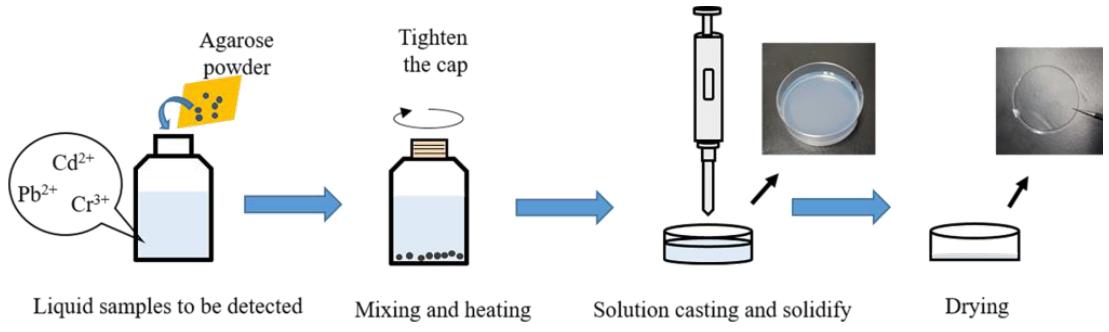
Figure 6. The preparation steps of the agarose hydrogel and agarose film samples.